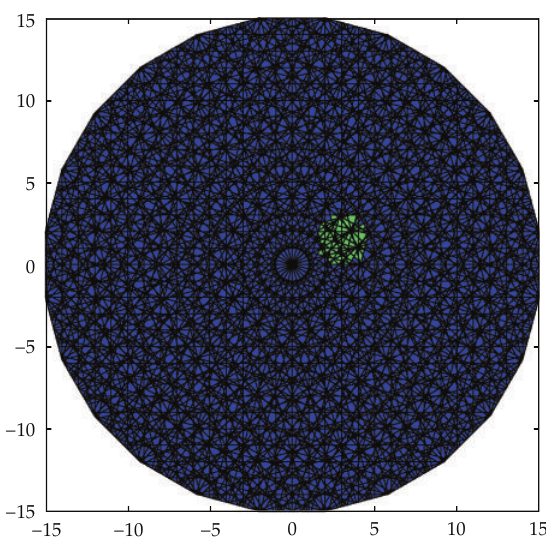
Figure 6: High-contrast nonhomogeneous model with 24 views and 30 × 30 pixels